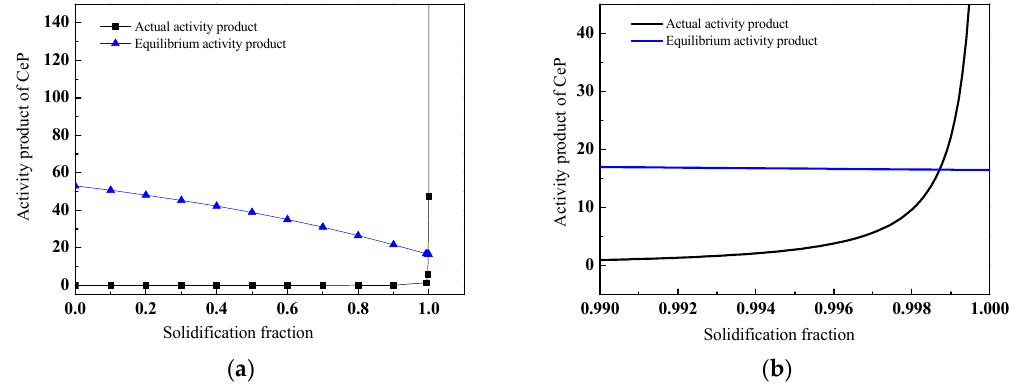
Figure 10. The actual activity product and equilibrium activity product of CeP. ( a ) Whole solidification process; ( b ) the solidification end.